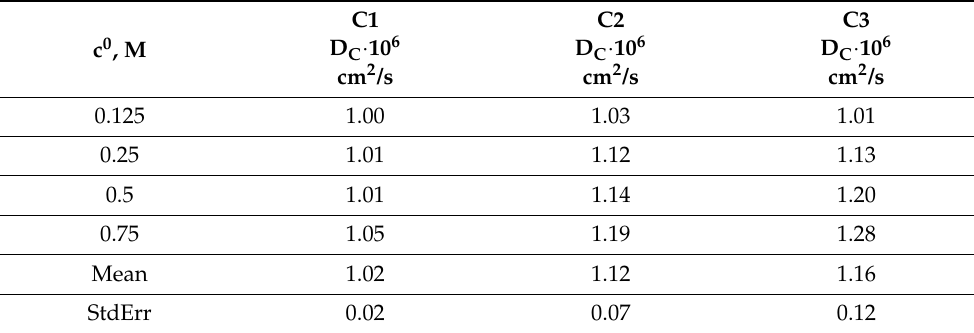
Table 4. Values of the diffusion coefficient of Br 2 inside the membrane, D C , based on results for various procedures, C1 to C3, in Table